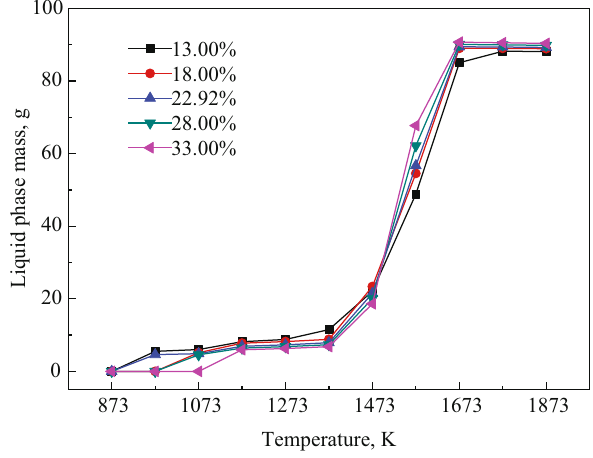
Figure 11: Relationship between liquid production and temperature under di ff erent Fe 2 O 3